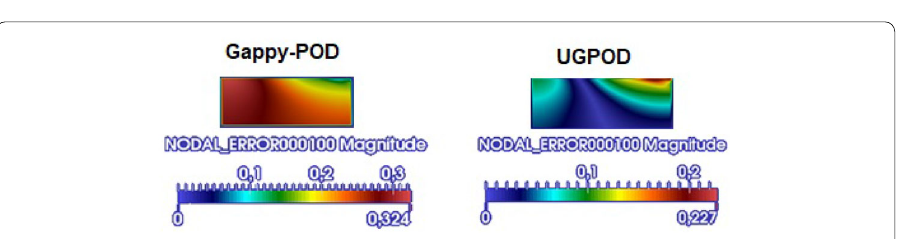
Fig. 10 On the left, the pointwise errors with the Gapp-POD. On the right, the pointwise errors with the